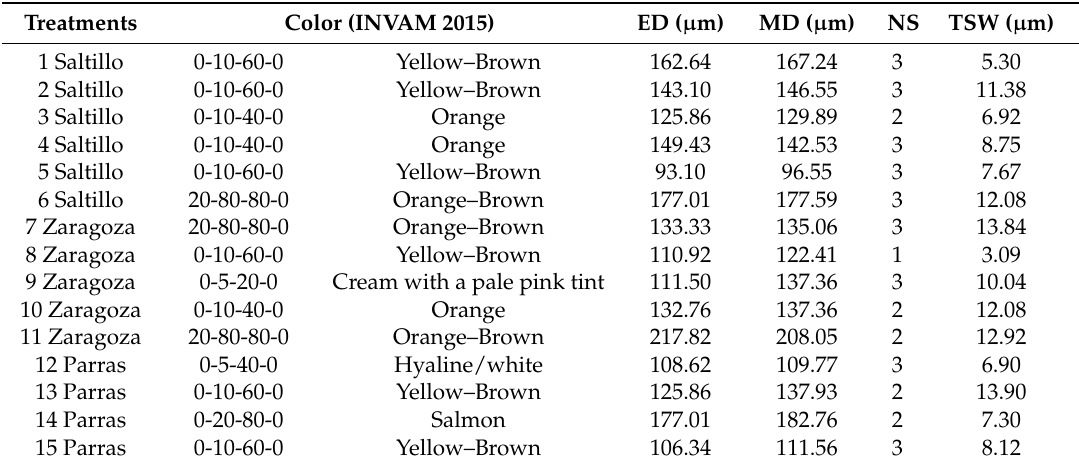
Table 2. Characteristics of native AMF associated with wild sunflower from Coahuila, 2015. Treatments